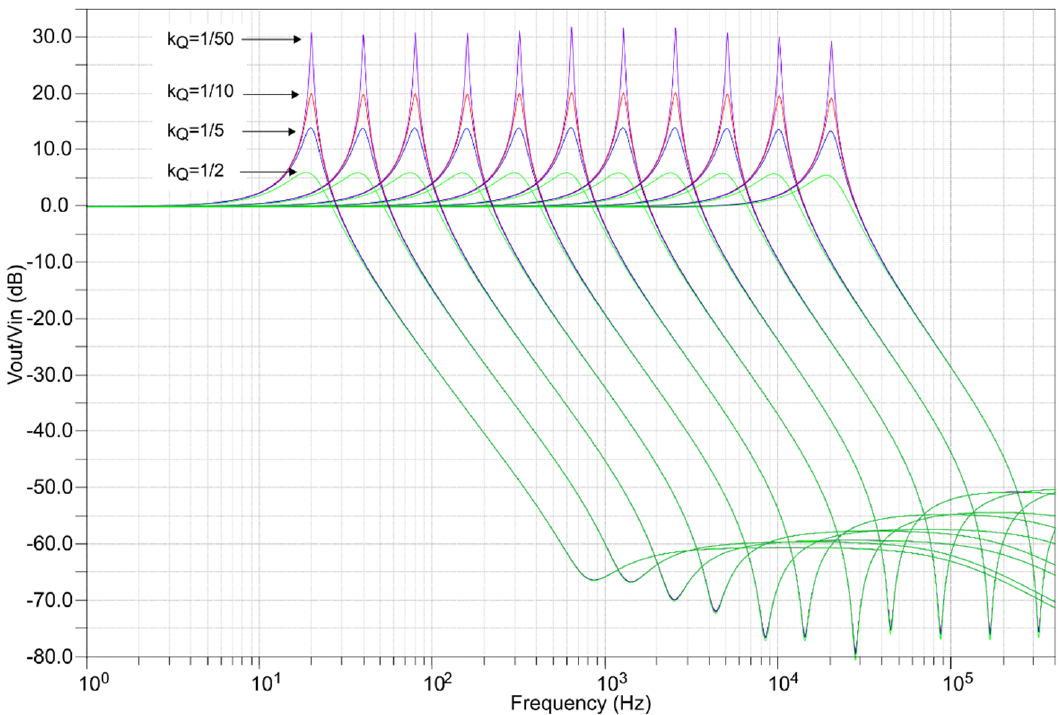
Figure 5. Amplitude responses of the filter bank simulated using nominal device models. The detailed values of the obtained peak gain magnitude, peak gain frequency f peak , and values of the factor Q BP are in Figure 6a–c. These figures show zoomed-in passband portions of the amplitude characteristics for the three selected filters: for the lowest (20 Hz), middle (1.28 kHz), and highest (20.48 kHz) frequencies,